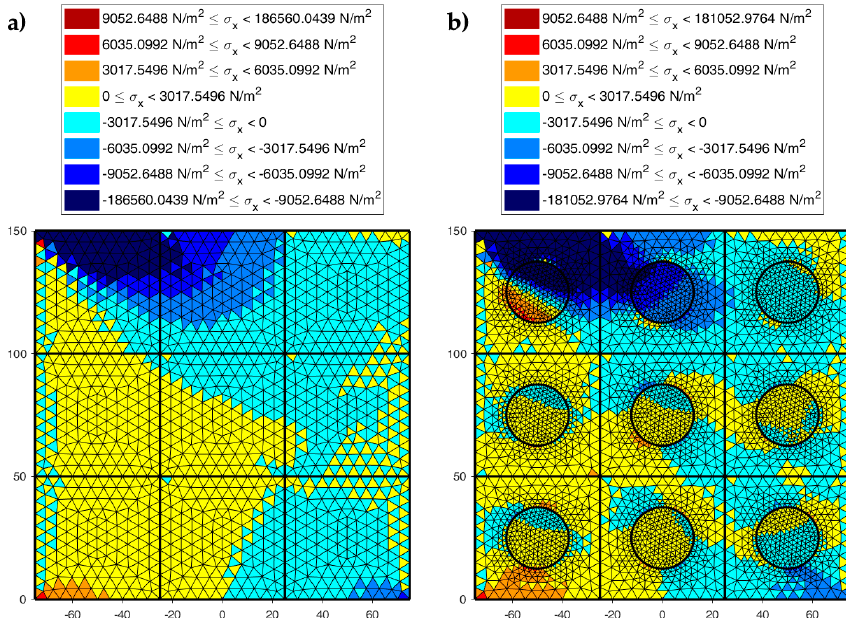
Figure 23. Normal stresses σ x (the x -axis runs horizontally) in the discrete elements of a 3 × 3 array subjected to shear load: ( a ) Without inclusions and ( b ) with round inclusions, which are stiffer than the matrix.